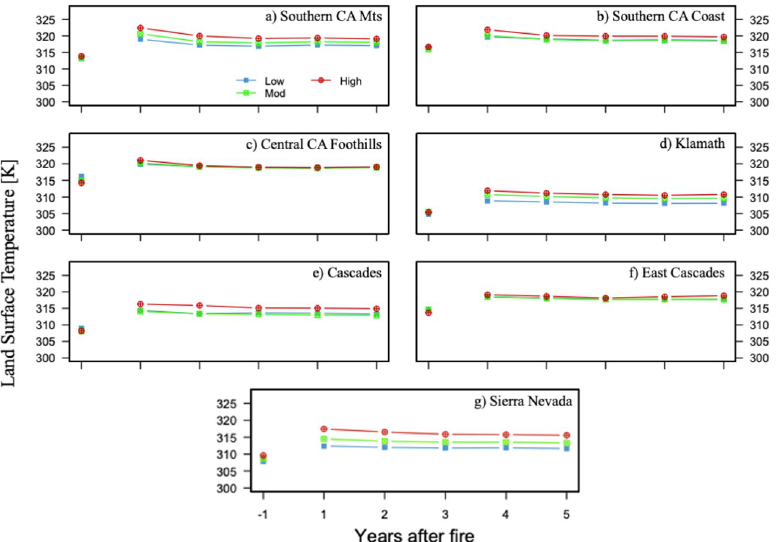
Fig 7. Prefire land surface temperature and five-year early-summer postfire trajectory (a-g). Average early-summer land surface temperature first-year pre-fire through five-years post-fire for each ecoregion SCM, SCC, CCF, K, C, EC, and SN. Prefire and postfire LST are burned area